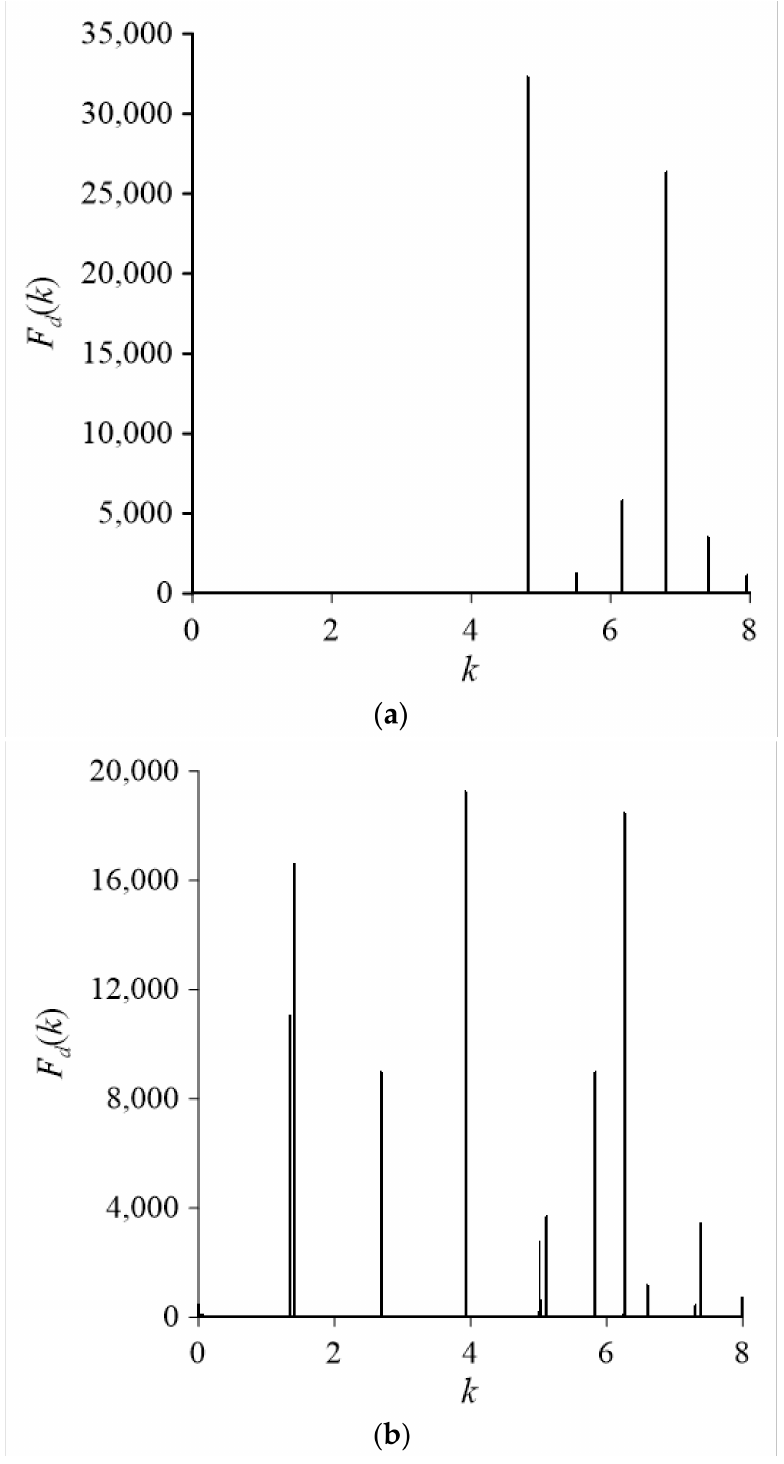
Figure 9. Resonance curves for eccentric annular waveguide for ( a ) TM mode and ( b ) TE